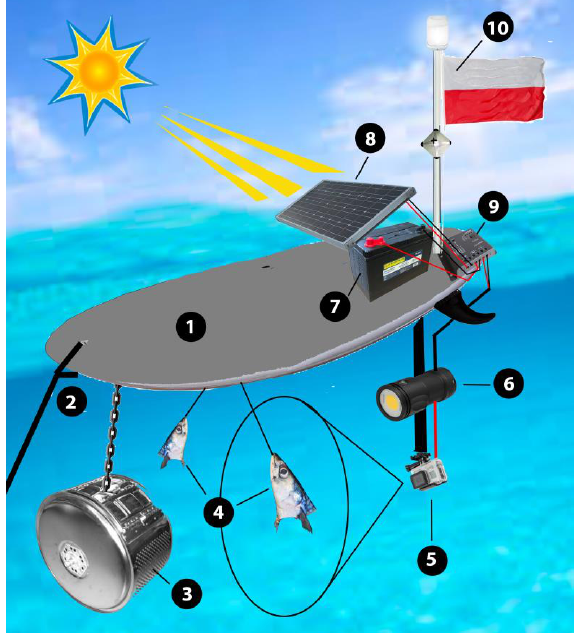
Figure 1. The BRUV includes the following components: (1) a surf board, (2) with an anchoring system, (3) (at a depth of 1 m) a drum with holes that houses the bait (inaccessible for the predators) displaying the long-lasting olfactive stimulus, (4) additional accessible bait (here fish heads) attached (hookless) to monofilament strings including a swivel, an underwater stick that supports a (5) GoPro in a waterproof housing and an (6) underwater white light (in a waterproof housing), which are both powered by a (7) battery that is charged by a (8) solar panel and its (9) controller. The security of the device (to avoid any accidental collision by ships) is insured through a mast including a banner, a radar reflector and a white light for night positioning. The battery and the controller (voltage regulator) are housed in a box (not illustrated) that supports the solar panel. Accessible bait (4) must be positioned in order to allow the camera (5) to record any fish attempting to feed on it.